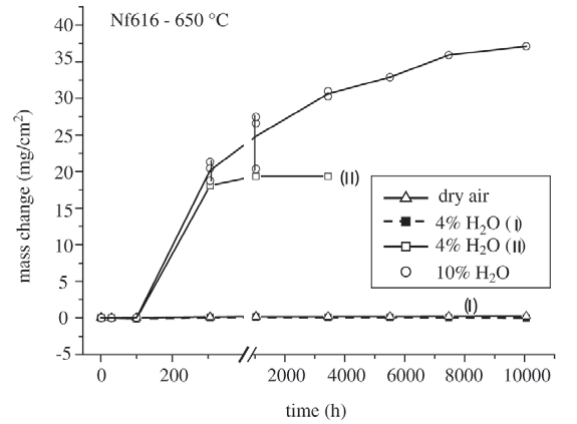
Figure 6. Results of mass change measurement as a function of time for steel Nf616 at 650 °C in different